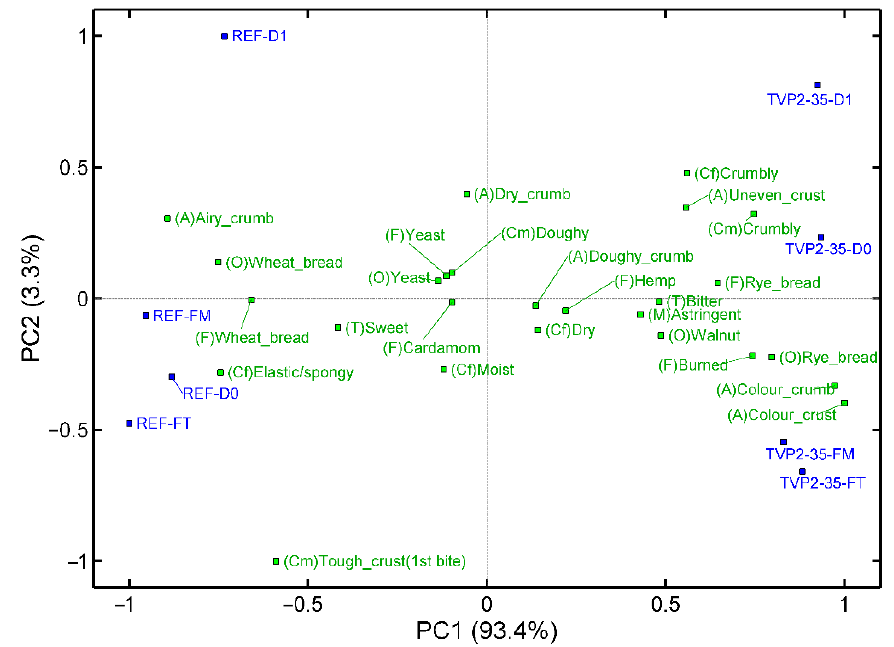
Figure 3. PCA biplot for the sensory profile of robustness of the selected buns. The reference (REF) had 0% added TVP; TVP1: extrudate with 10% faba bean, 89% pea, 1% salt; TVP2: extrudate with 49% faba bean, 40% pea, 10% quinoa, 1% salt; TVP3: Extrudate with 10% faba bean, 79% pea, 10%